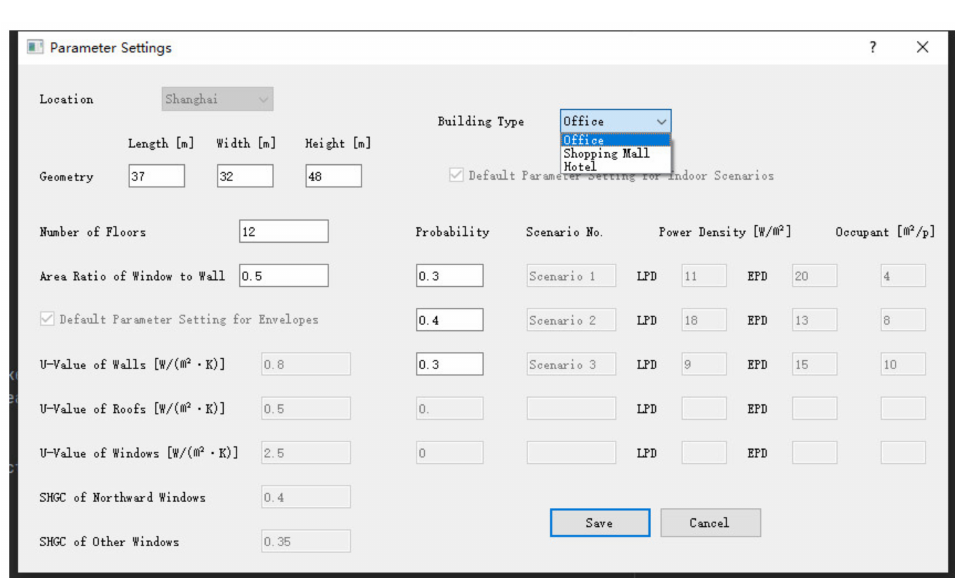
Figure 19. UI of the detail parameter